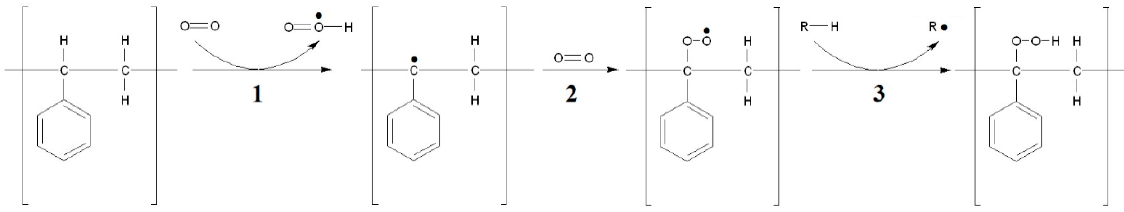
Figure 13. The possible scheme of formulation of tertiary peroxide by oxygen reaction using PS chain. The following symbols were applied: 1—an attack of an oxygen molecule on a PS molecule with formation of a radical; 2—an attack of an oxygen molecule on a radical located on a tertiary carbon atom; 3—transfer of hydrogen from cleavage of the C ‐ H bond of the polymer structure with formation of a hydroperoxide.